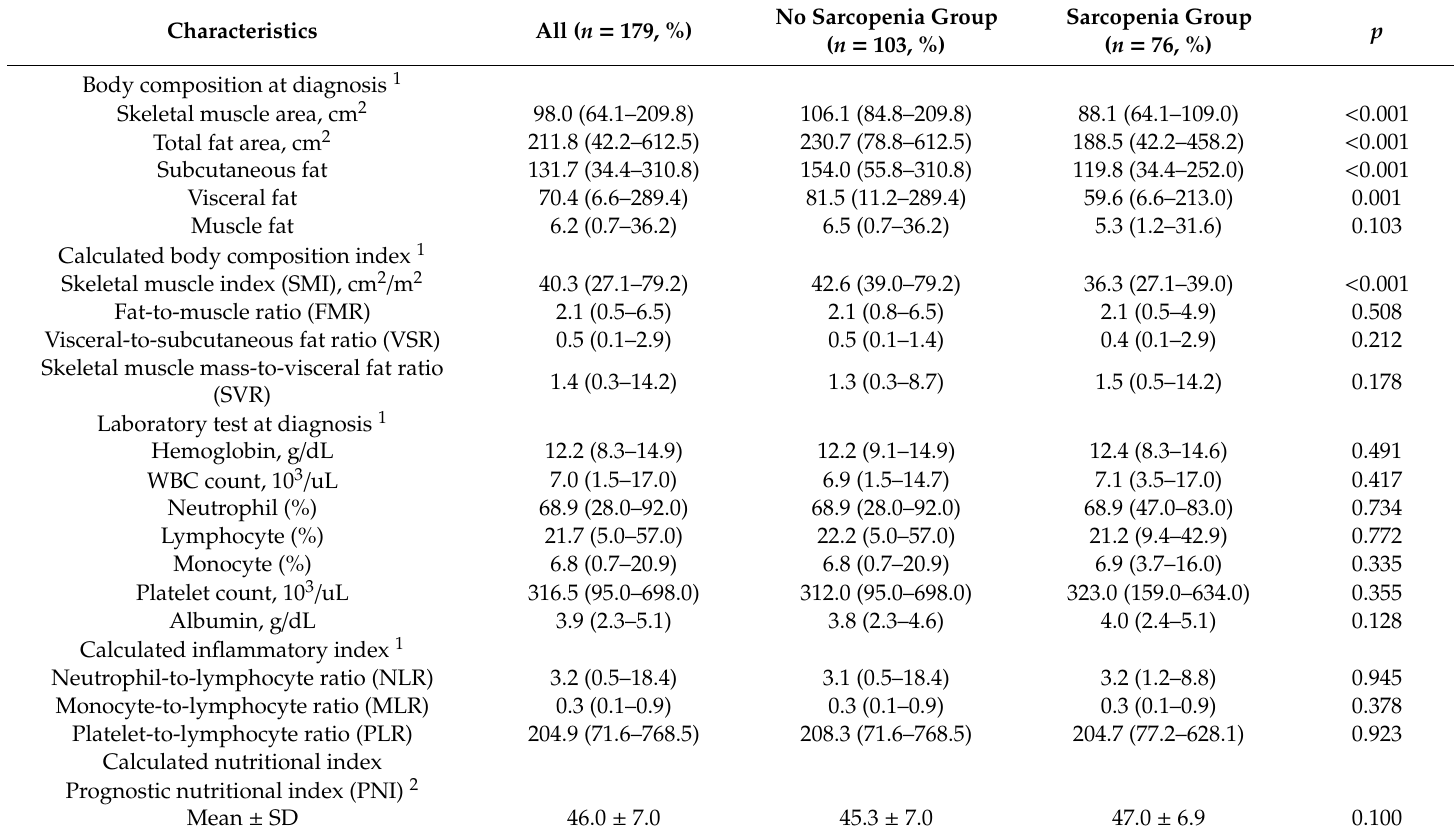
Table 2. Body composition and laboratory results of all